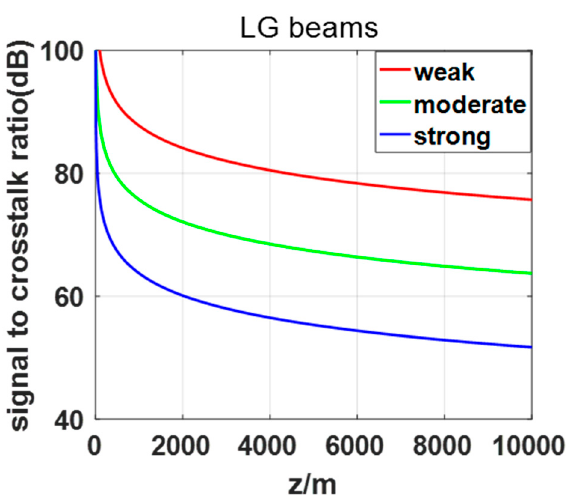
Figure 10. Signal-to-crosstalk ratio with transmission path after adaptive compensation.